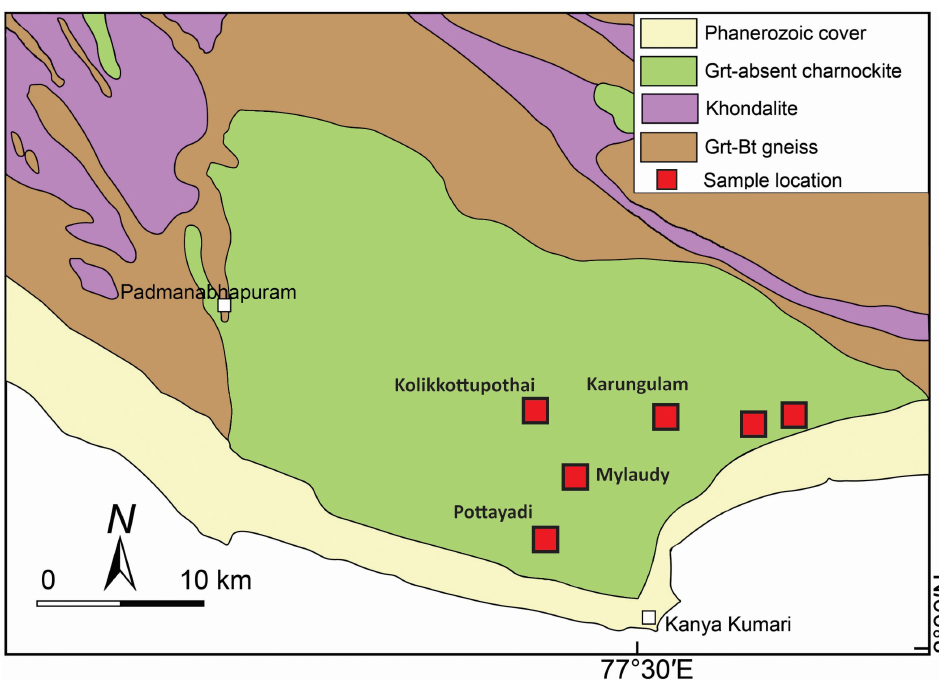
Figure 2. Geological map of Nagercoil block with sampling locations.